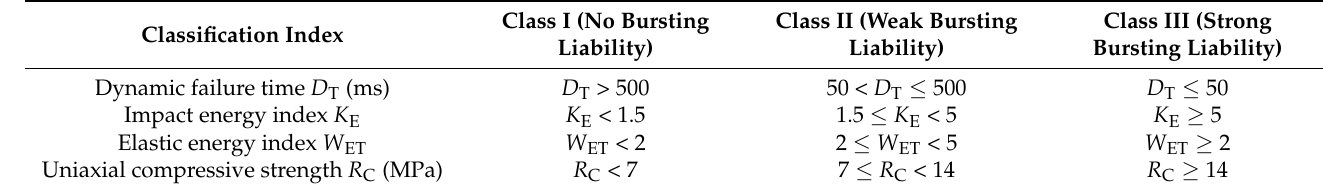
Table 1. Classification Method for Coal Seam Bursting Liability and Indexes.